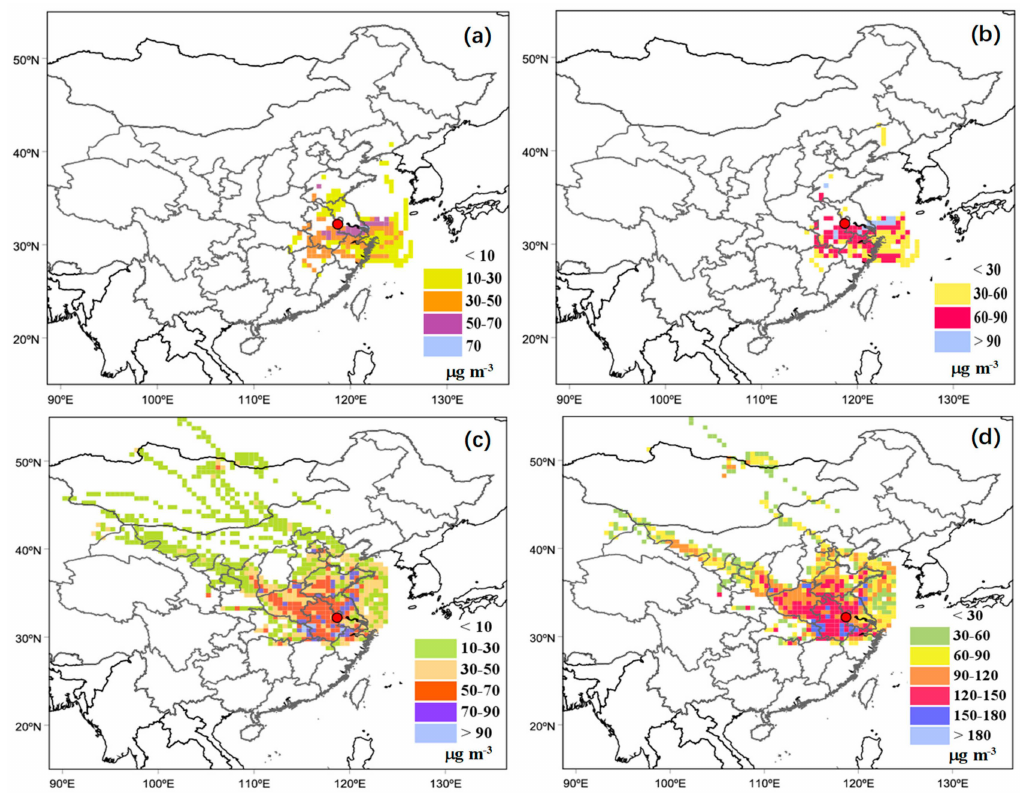
Figure 9. Concentration-weighted trajectory (CWT) method analysis maps for particulate matter, PM 2.5 ( a ) summer, ( c ) winter and PM 10 ( b ) summer, ( d )